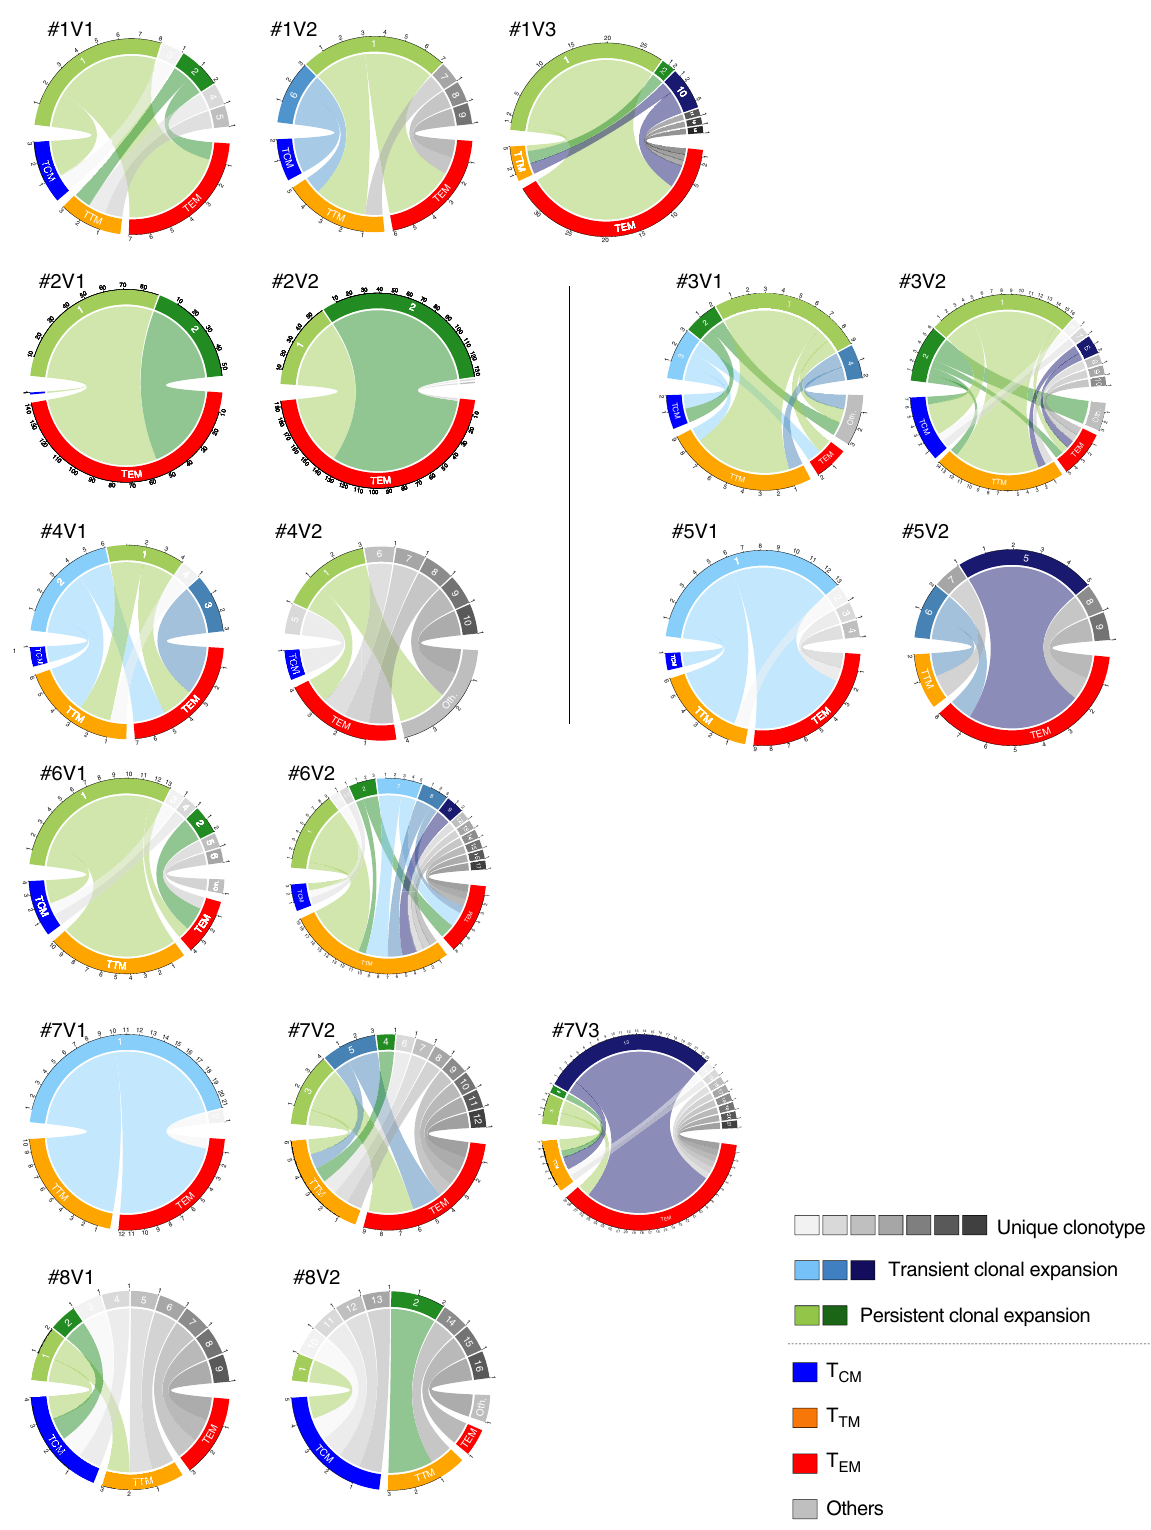
Fig. 4 TCR β clonotypes from p24 + cells display multiple memory phenotypes. The distribution of TCR β clonotypes of p24 + cells among memory subsets is represented as a chord diagram for participants #1 to #8 at each study visit (V1, V2, and V3). The circular representation shows the link between a speci fi c clonotype (top half of the circle) and its memory phenotype (bottom half of the circle). The circular axis represents the number of p24 + cells in each clonotype/subset. Expanded clonotypes persisting over time are depicted in shades of green; Expanded clonotypes detected at a single visit are depicted in shades of blue; Unique clonotypes are depicted in shades of gray. The memory subset color code is as follows: central memory (T CM ) in blue; transitional memory (T TM ) in orange; effector memory (T EM ) in red; and unde fi ned (others) in gray. Source data are provided as a Source Data fi